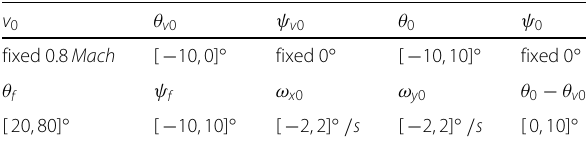
Figure 22 plots the success rate and the execution time depending of the number of nodes. The test case is the planar maneuver with the regularization parameter K set to 5.5 × 10 3 . The rate of success does not increase